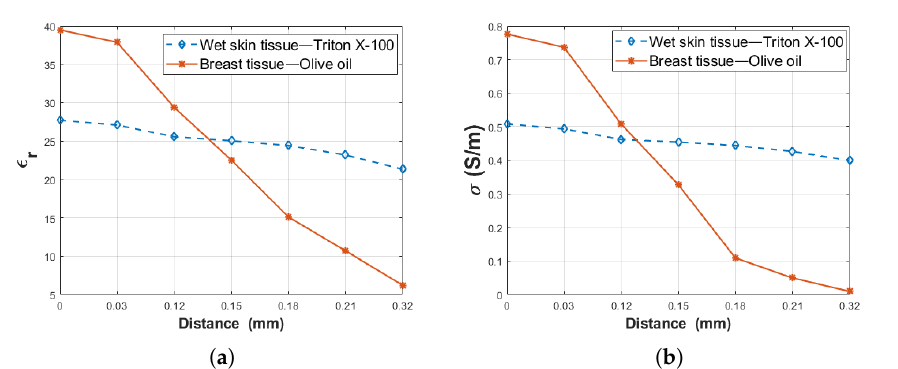
Figure 12. The comparison dielectric property alteration of rat wet skin tissue-triton X-100 and rat breast tissue-olive oil as a function of probe tip distance (D n ): ( a ) relative permittivity and ( b )